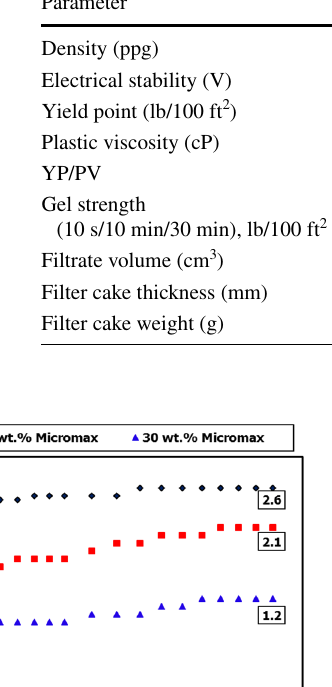
Table 3 Summary of the drilling fluid properties